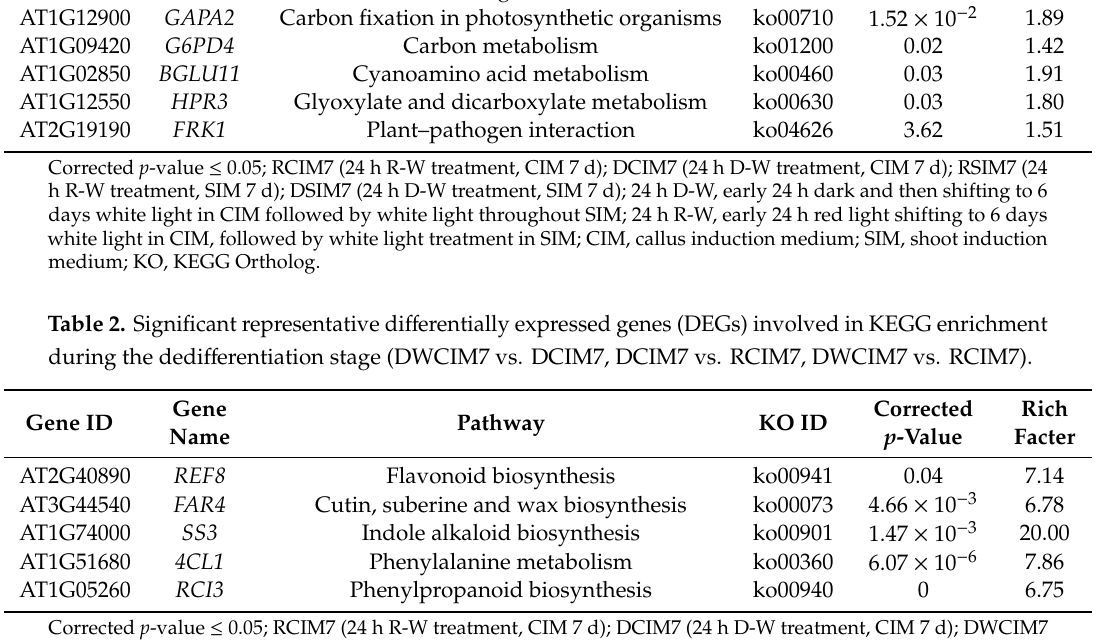
Table 1 (transitional stage, DCIM7 vs. DSIM7, RCIM7 vs. RSIM7), Table 2 (dedi ff erentiation stage,